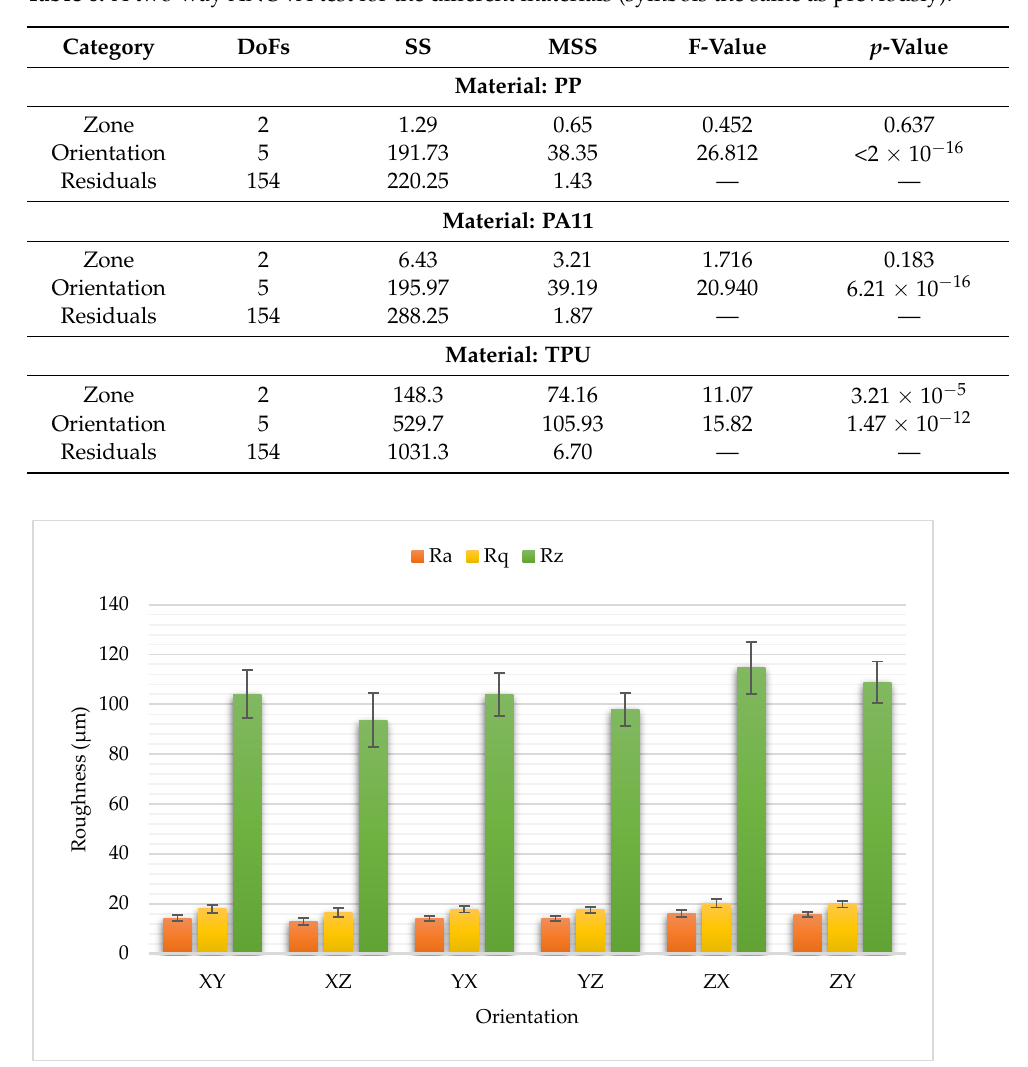
Table 6. A two-way ANOVA test for the different materials (symbols the same as previously).